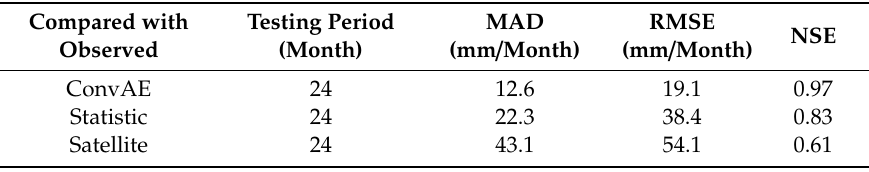
Figure 8. Comparing the correlation of the monthly total precipitation of the data sources over the Mekong basin during the testing period.